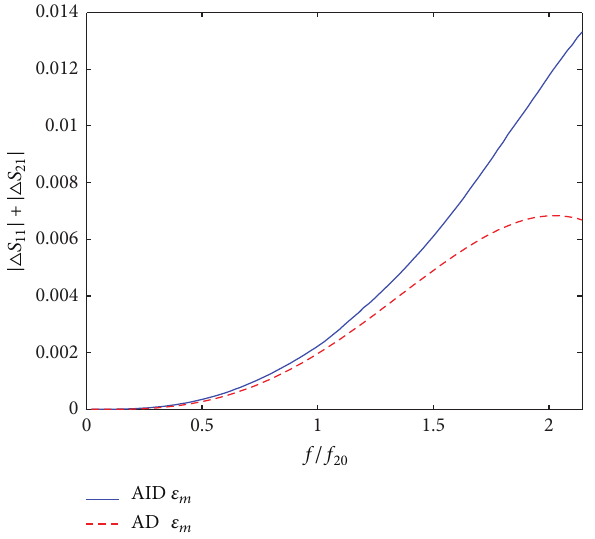
Figure 16: The 𝑆 -parameter differences at 𝜃 0 = 60 ∘ for two ABL- models. Solid curve: the case with angle-independent (AID) 𝜀 𝑚 (= 𝜀 𝑚 ( 𝜃 0 = 0 ) of IBL-model); dashed curve: with angle-dependent (AD) 𝜀 𝑚 .